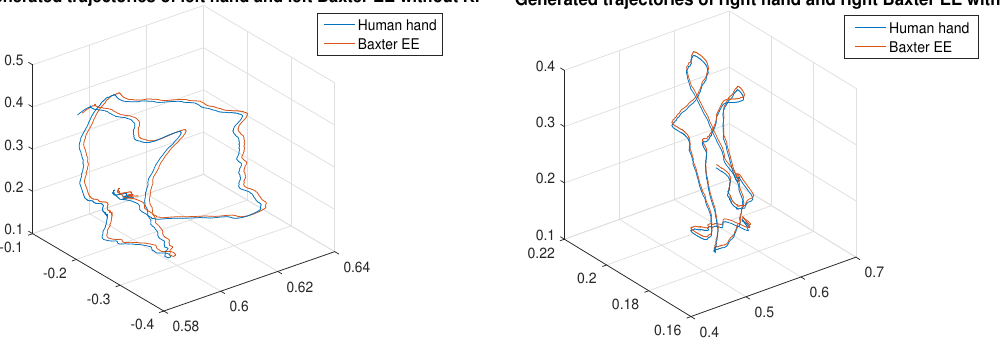
Generated trajectories of right hand and right Baxter EE without KF